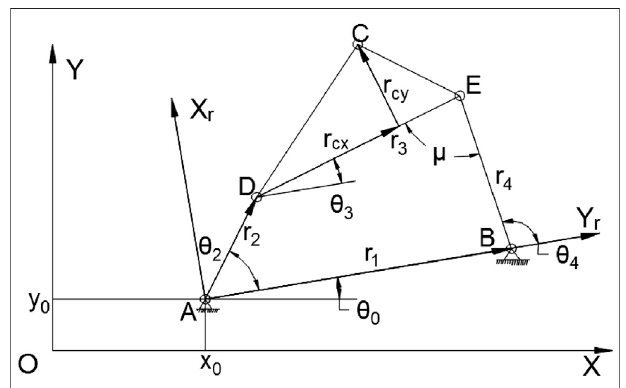
FIGURE 1 | A planar four-bar mechanism with design